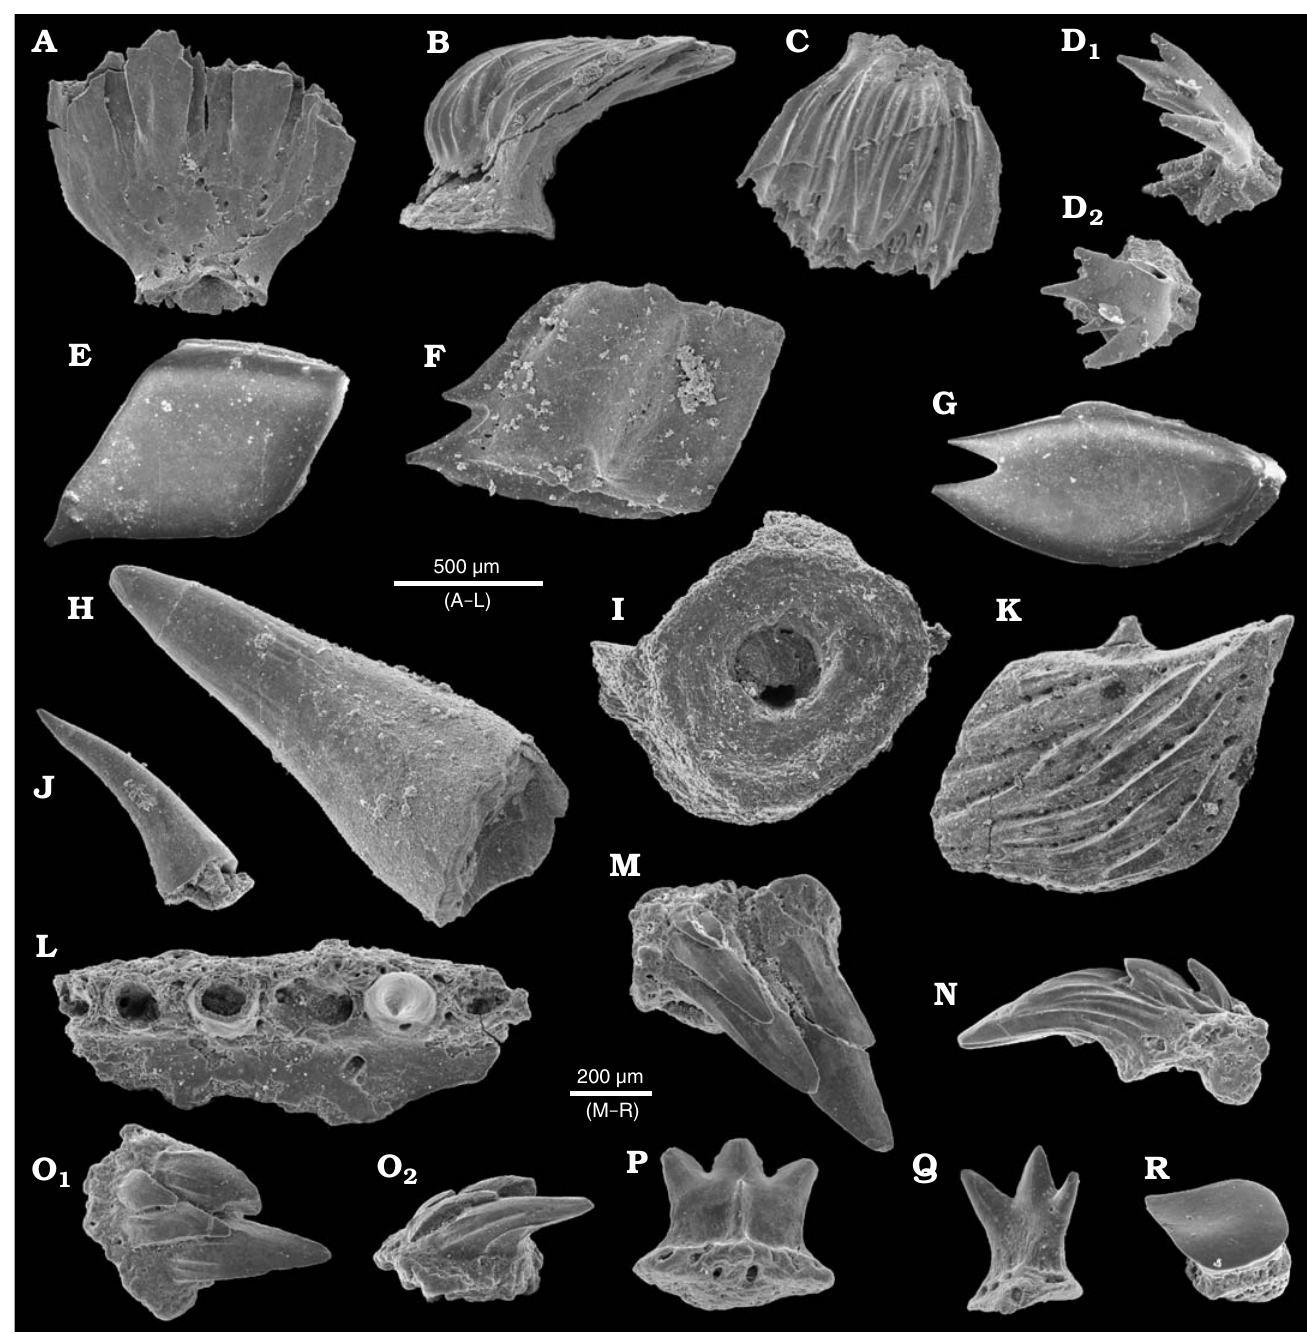
Fig. 6. Ichthyoliths from the upper Viséan of Czerna, Poland (A–K) and the Tournaisian of Czatkowice, Poland (L–R). A – C . Ctenacanthoid